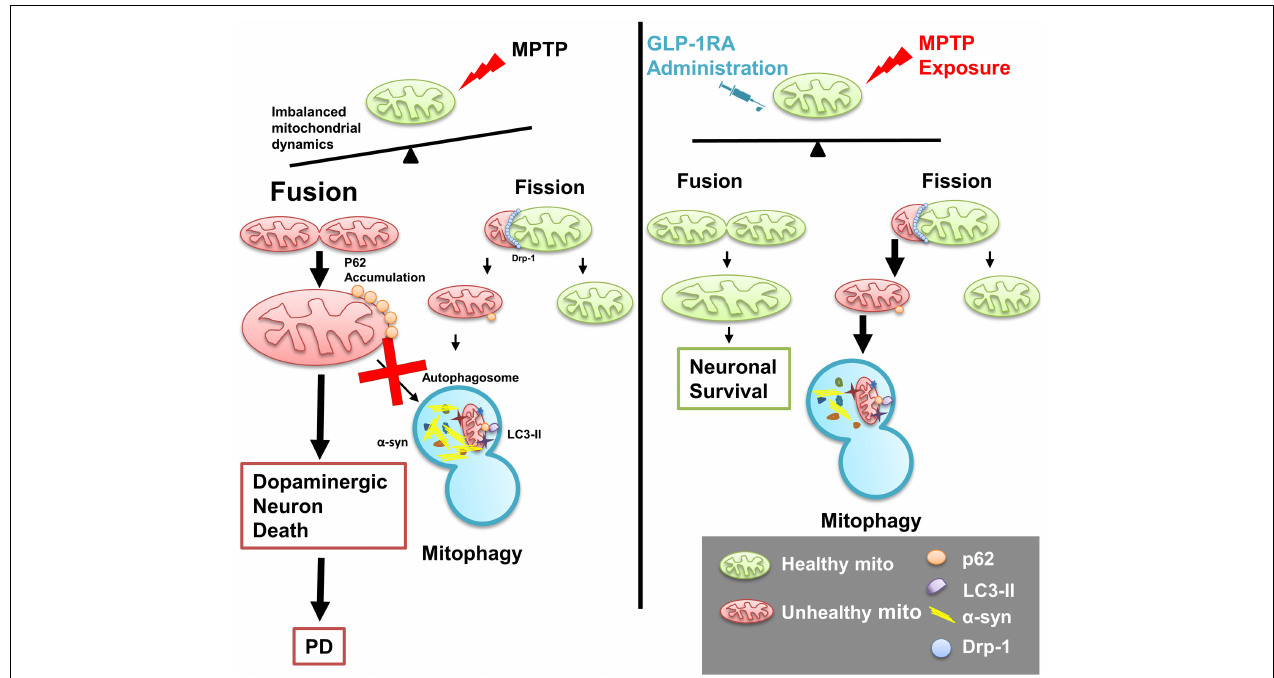
FIGURE 8 | Schematic diagram of the role of the GLP-1RA (liraglutide) in mediating MPTP-induced imbalanced mitochondrial fusion and fission and rescuing neurotoxin-induced neuronal death. In a PD mouse model, the mitochondrial complex I inhibitor MPTP causes loss of dopaminergic neurons and imbalance of regulators involved in mitochondrial morphology dynamics. Enlarged mitochondria (mega-mitochondria) are formed as an adaptive process under stress and apoptosis is induced once the stress is overwhelming, and reduced autophagosomal formation is associated with enhanced α -syn accumulation and elevated oxidative stress. The T2DM drug GLP-1RA, liraglutide, rebalanced mitochondrial dynamics, enhanced autophagy flux, and provided a neuroprotective effect. Mito, mitochondria; p62, p62/Sequestosome 1 (SQSTM1); LC3-II, microtubule-associated protein 1A/1B-light chain 3; α -syn, α -synuclein; Drp1, dynamin-related protein